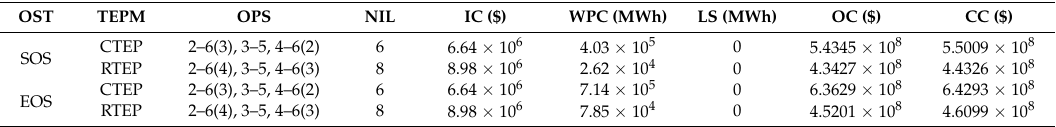
Table 2. Results of the proposed RTEP method and the conventional TEP (CTEP) method for Garver’s 6-bus system 1 .